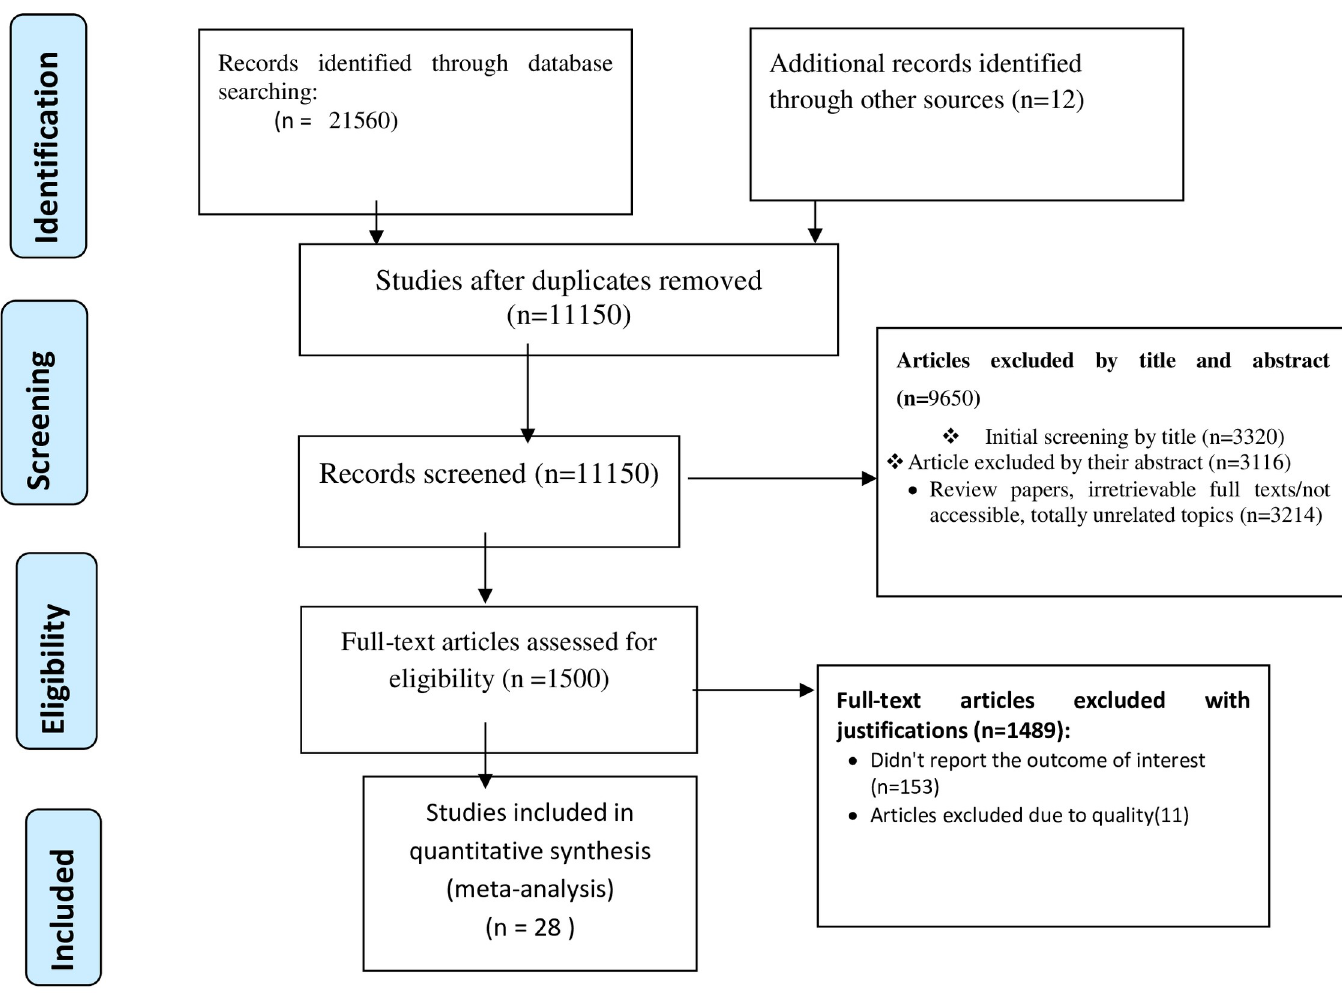
Fig 1. PRISMA flow diagram showed the results of the search and reasons for